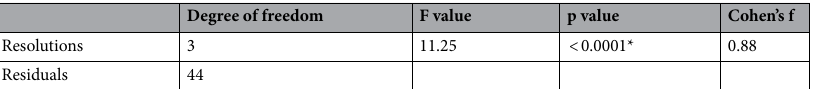
Table 2. ANOVA of the 12 dentists’ d prime for each resolution. The statistical power was 0.99, which indicated that 12 dentists were enough to perform our study. * represents p < 0.05.